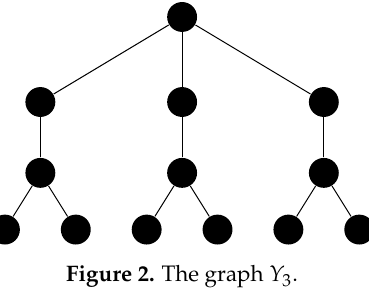
Figure 2. The graph Y 3